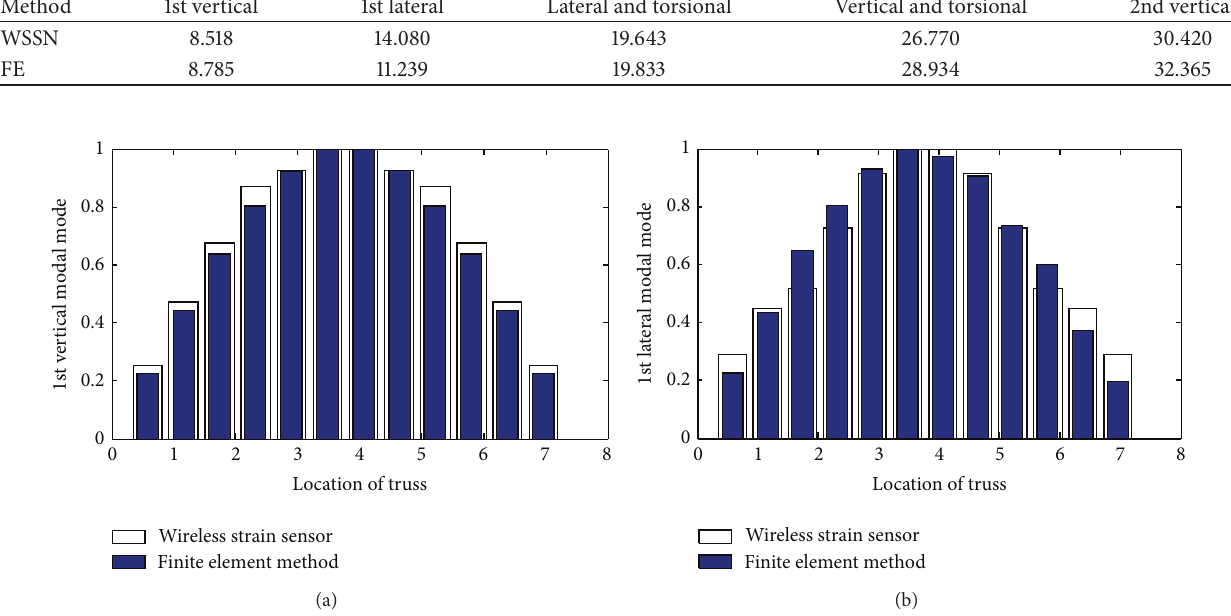
Figure 25: Modes identified by the WSSN: (a) 1st vertical mode and (b) 1st lateral mode.